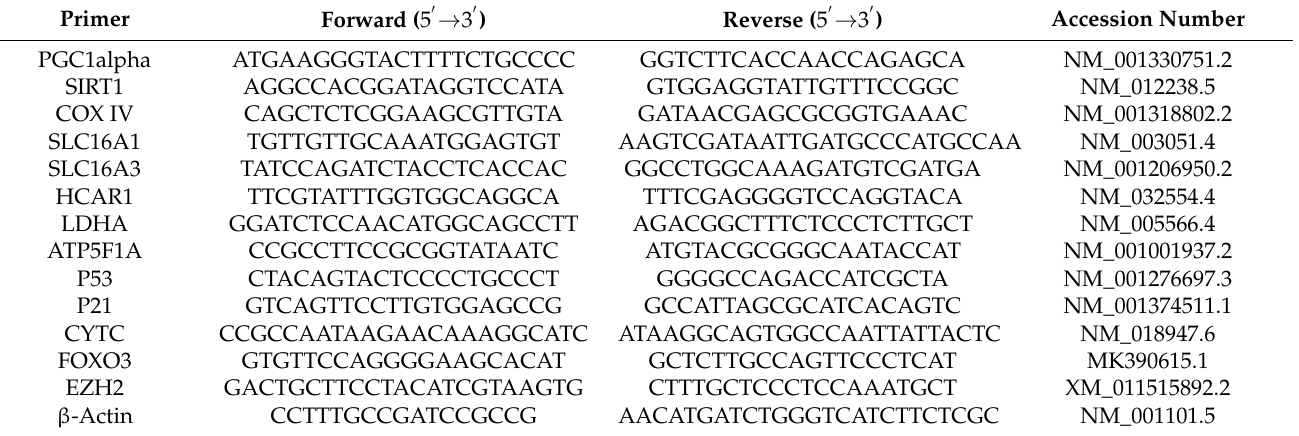
Table 1. Primers’